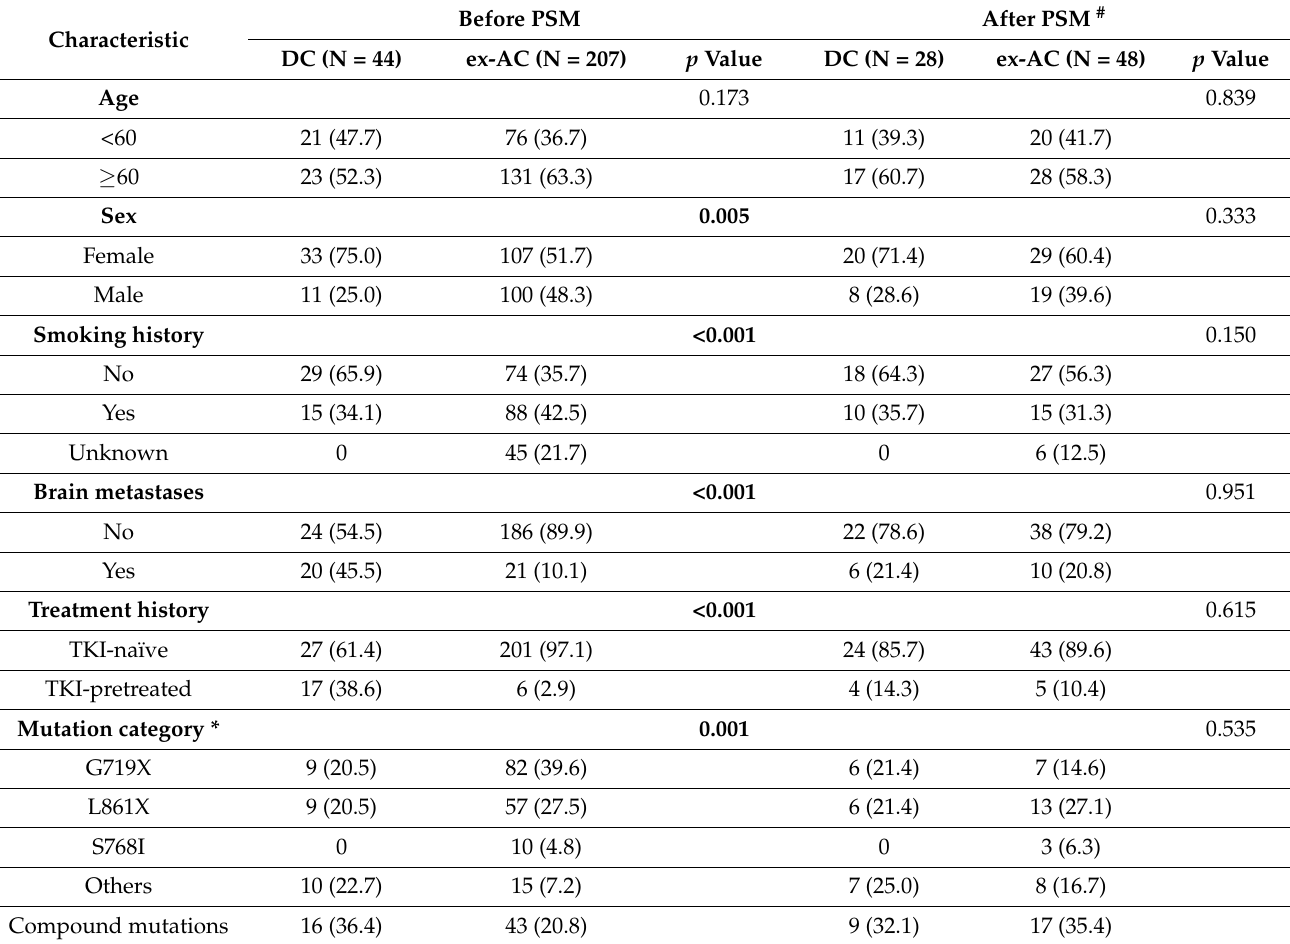
Table 4. Baseline characteristics of the DC and the ex-AC before and after PSM (1:2